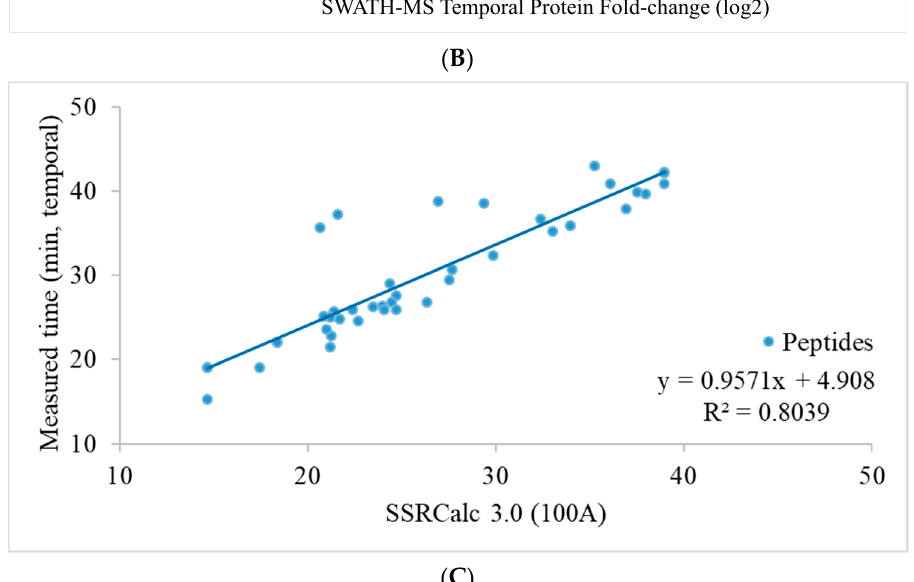
Figure 4. Relationship between protein quantification using SWATH-MS and targeted MRM-MS approaches in the temporal retinal quadrant two weeks after pONT. ( A ) Significantly differentiated retinal proteome in the temporal quadrant after pONT compared to control. The bar chart shows the average protein fold change with standard deviation ( n = 4, p < 0.05, 1% FDR). ( B ) The retinal proteome fold-change correlation in the temporal quadrant 2 weeks after pONT treatment, meas- ured using independent MRM-MS and SWATH-MS experiments with high regression (R 2 = 0.965) and Pearson’s correlation (R 2 = 0.958) on differentially expressed proteome. GAPDH was included as a reference. ( C ) Retention time linear regression plot of total 99 MRM transitions, governing 33 peptides used for the identification and fold-change calculation of 11 temporal proteins ( n = 4, in triplicate).